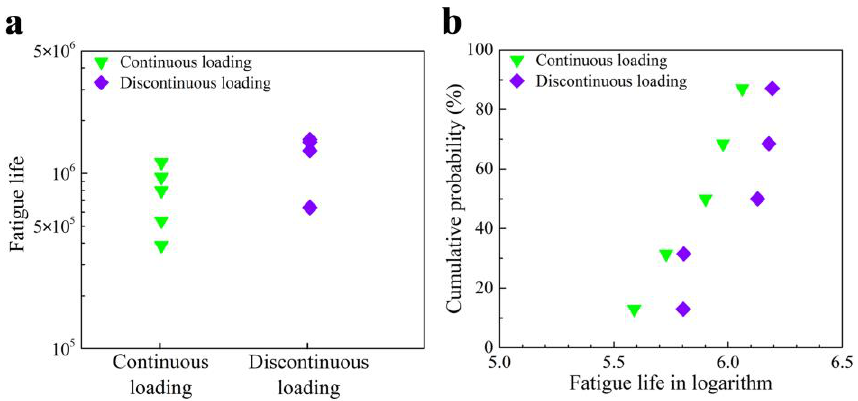
Figure 10. Comparison of fatigue life of 25CrMo4 specimens under continuous cyclic loading and discontinuous cyclic loading. ( a ) Fatigue life of the two loading conditions, ( b ) cumulative probability of fatigue life in logarithm.